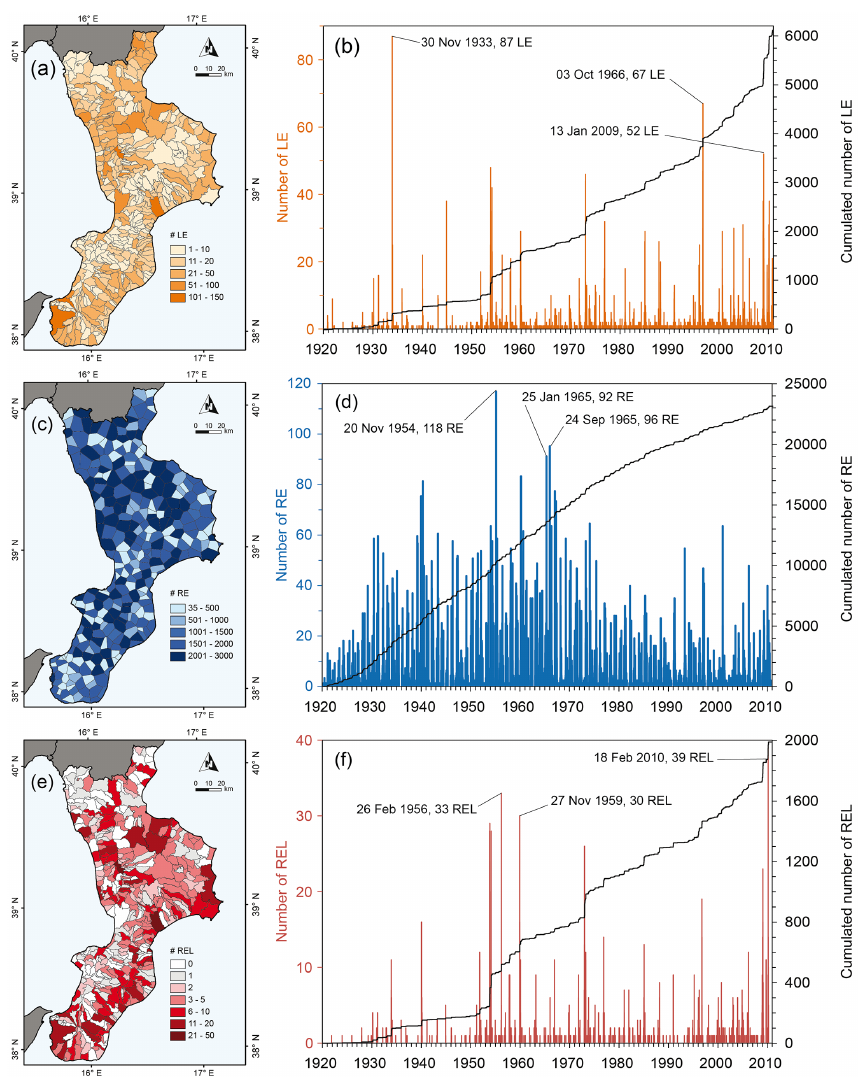
Figure 2. (a) Number of landslide events (LE) in each municipality in Calabria in the 90-year period 1921–2010. (b) Temporal distribution of LE (orange bars), and cumulated number of LE (black line) in the period 1921–2010. The 3 single days with the largest number of LE are shown. (c) Number of rainfall events (RE) reconstructed for each rain gauge in the period 1921–2010. Reference area for each rain gauge is shown using Thiessen polygons. (d) Temporal distribution of reconstructed RE (blue bars), and cumulated number of RE (black line) in the period 1921–2010. The 3 single days with the largest number of RE are shown. (e) Number of rainfall events (REL) in each municipality in the period 1921–2010. (f) Temporal distribution of REL (red bars), and cumulated number of REL (black line). The 3 single days with the largest number of REL are